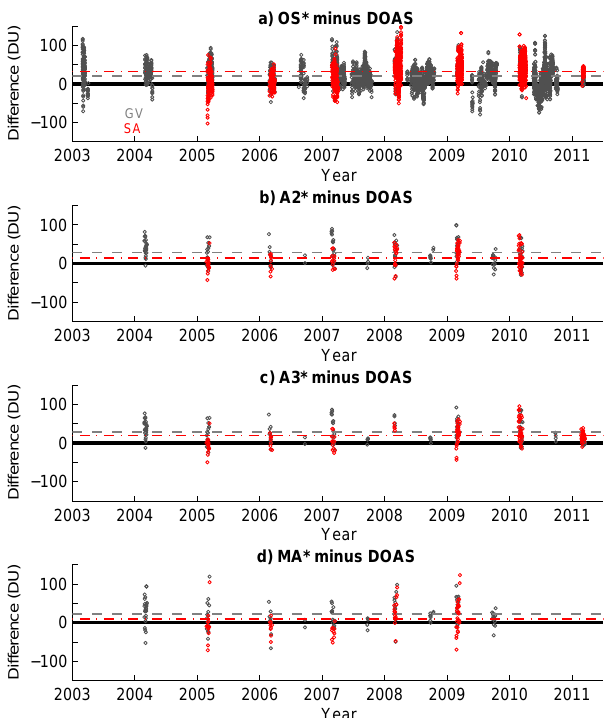
Fig. 8. Absolute differences (circles) and mean absolute differences (dashed lines) between satellite-plus-ozonesonde and Bruker FTIR (grey) and Brewer (red). The solid black lines indicate